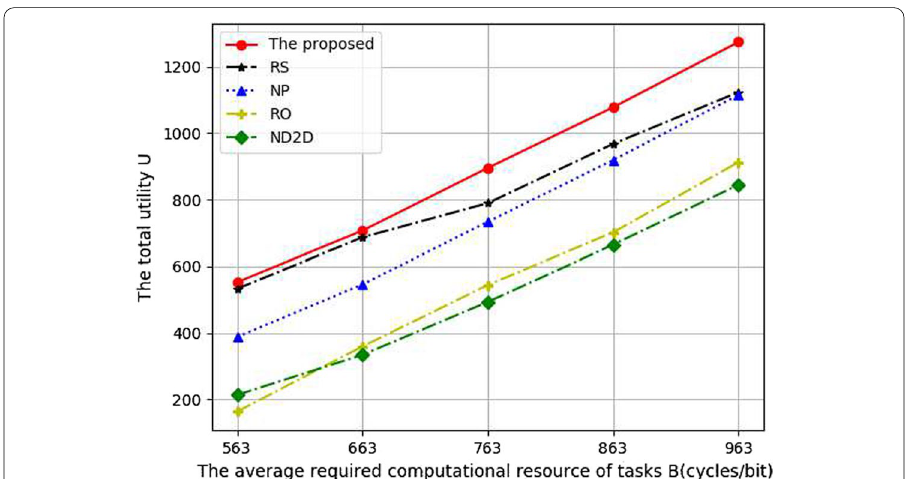
Fig. 8 The total utility of UEs over the average required computational resource of